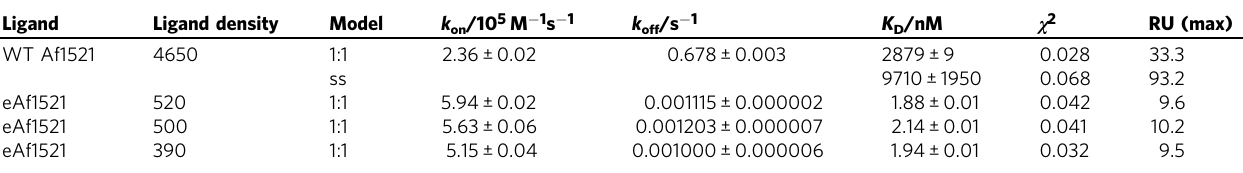
Table 1 Kinetic data for binding of ADPr to eAf1521 and WT Af1521, respectively.